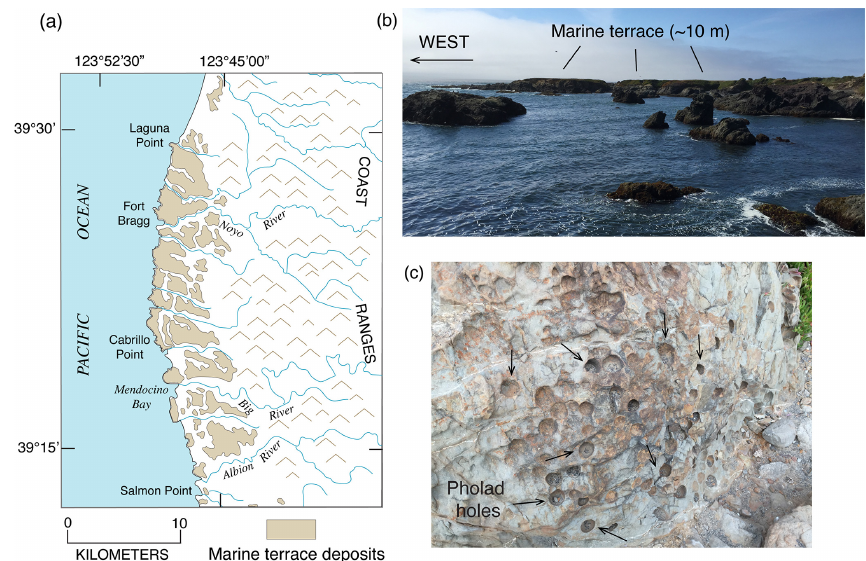
Figure 22. (a) Map showing the distribution of marine terraces in the Laguna Point–Fort-Bragg–Cabrillo Point area (redrawn from Jennings and Strand, 1960); (b) photograph of 10m high marine terrace near Laguna Point, correlated to MIS 5e (Merritts and Bull, 1989); (c) pholad holes in outer edge of 10m high, MIS 5e terrace. Photographs by Daniel R.